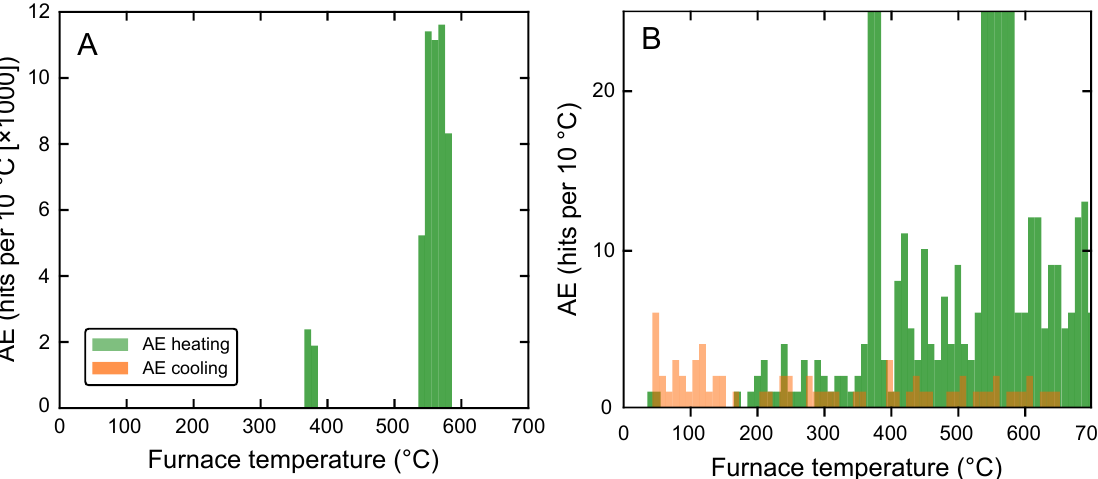
Figure 9: [A] The number of acoustic emission (AE) hits per 10 ◦ C recorded during a thermal stressing experiment on Mt. Epomeo Green Tu ff (MEGT) to a maximum temperature of 700 ◦ C. [B] A graph showing a zoom of the data shown in panel [A] to highlight the AE hits recorded during cooling.